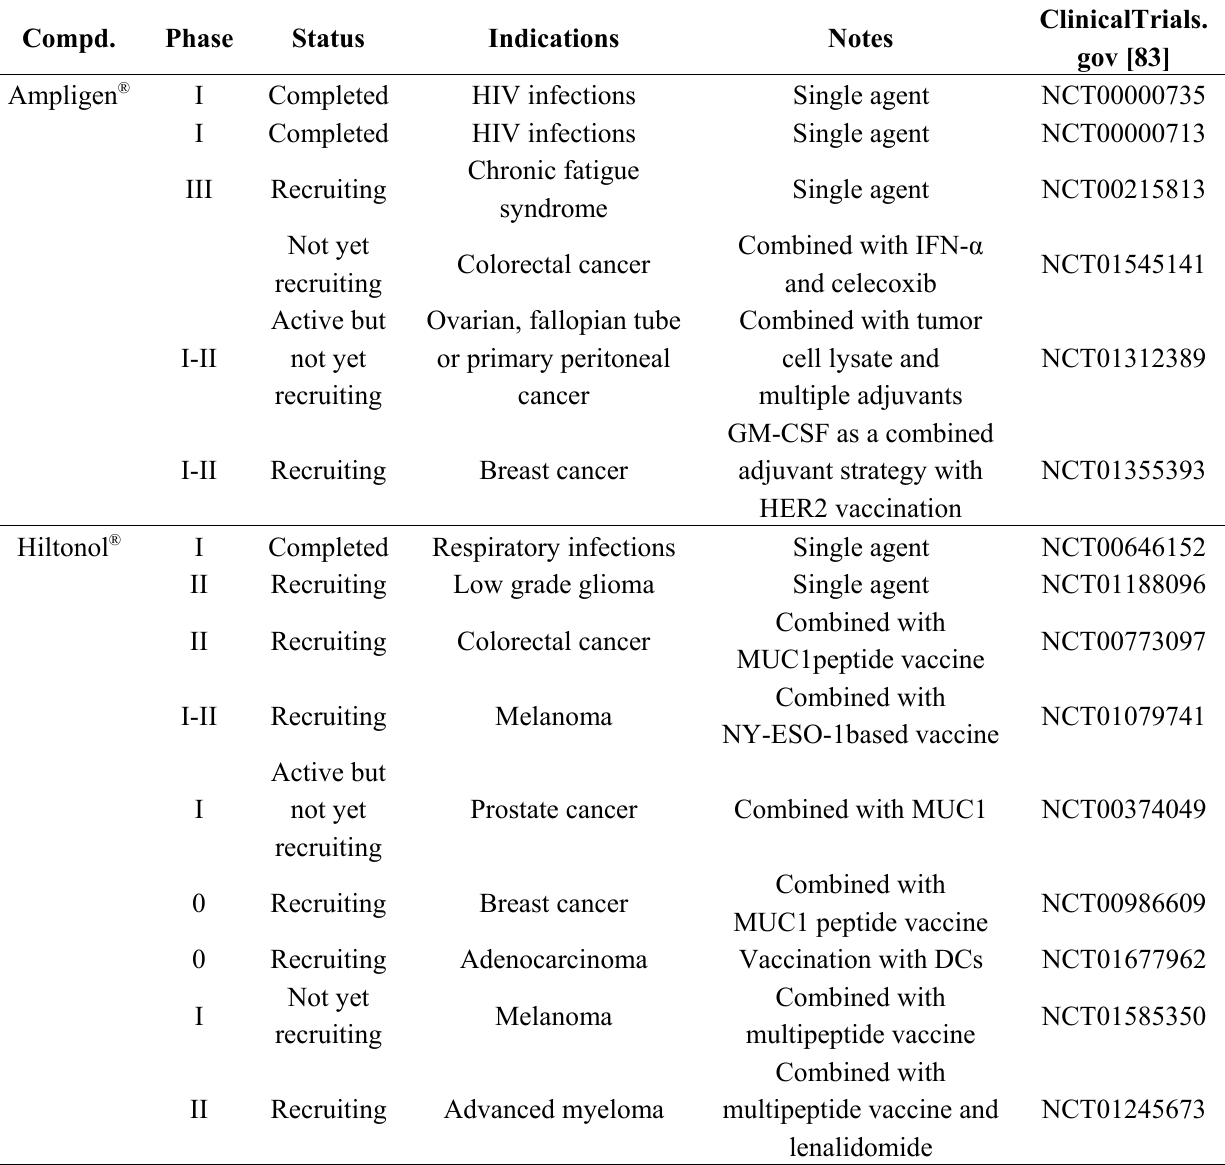
Table 1. Clinical status of TLR3-recognizing nucleic acid analogues.